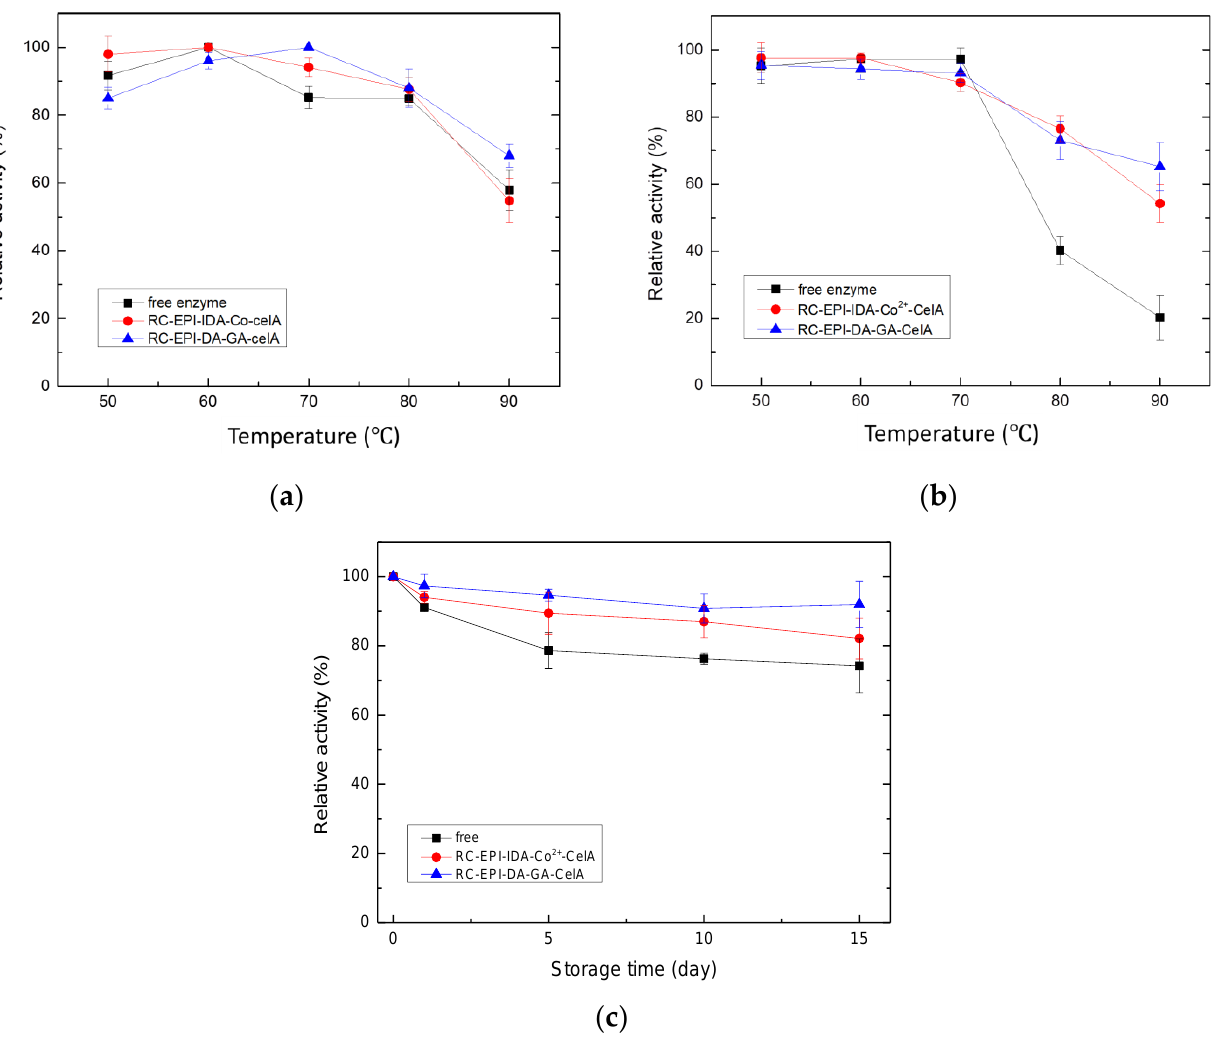
Figure 8. ( a ) Optimum temperature, ( b ) thermo-stability, and ( c ) storage stability of free and immobi- lized CelA